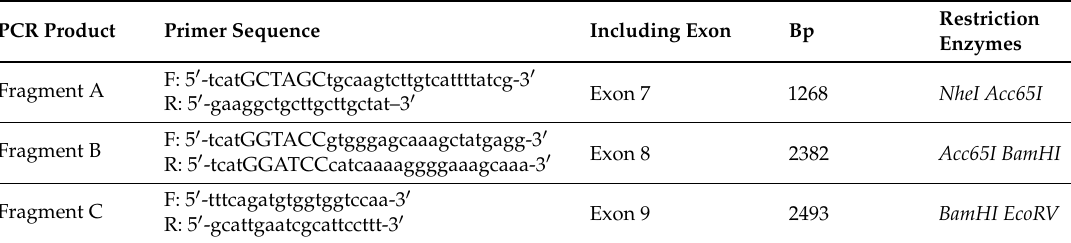
Table 2. Minigene primer